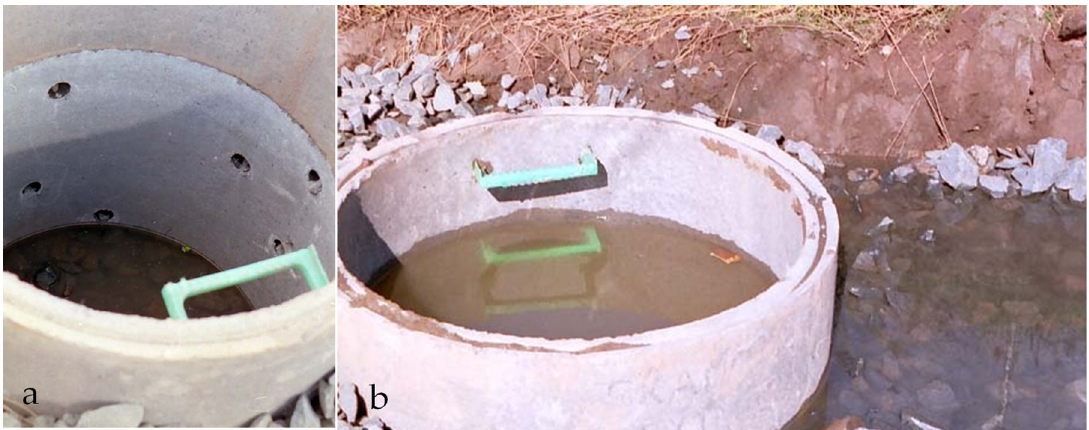
Figure A24. Abstraction device (1.2 m OD), which was designed to access water within a shallow groundwater mound. ( a ), constructed device showing a perforated chamber surrounded by coarse gravel, with interception of the feather edge of the groundwater mound at its base. The water level is >1.2 m below the ground surface; ( b ), the same abstraction infiltration device 24 h later, showing the groundwater mound surface located 0.2 m below the ground surface.